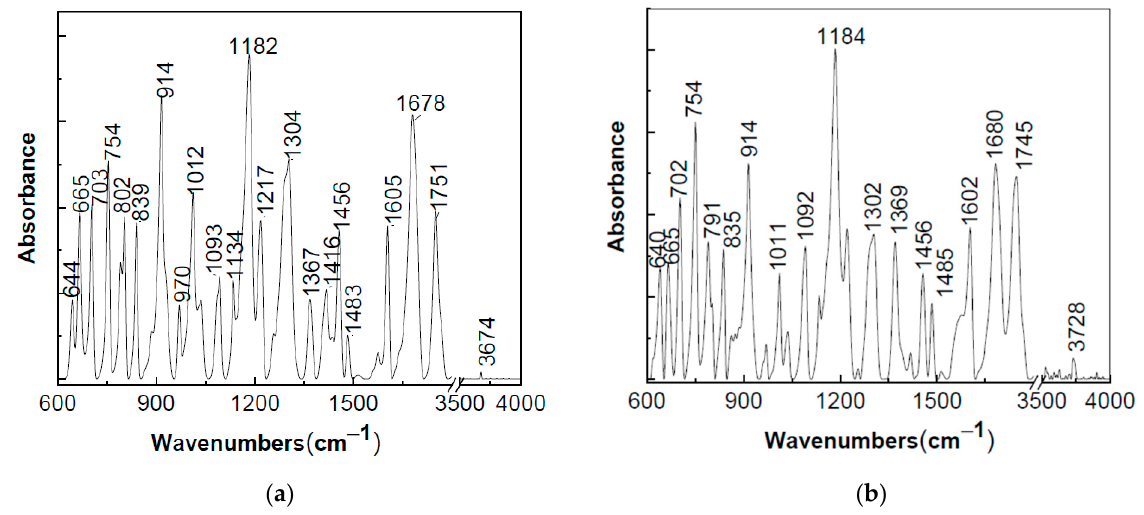
Figure 7. The IR spectra of ASA in the initial state ( a ) and after interaction with NaOH ( b ). Figure 8 highlights the dependence of PLE and PL spectra of the aqueous solution of ASA 0.3 M as function of the